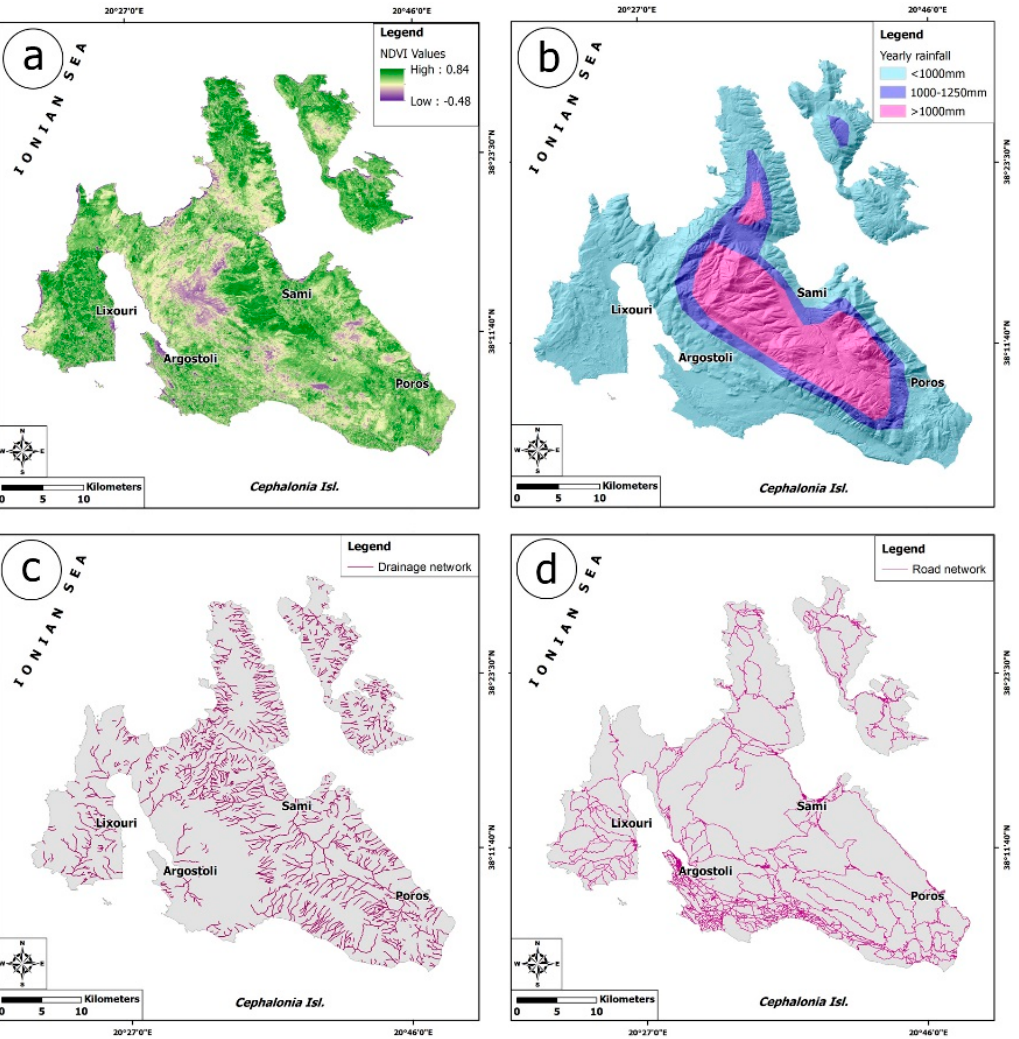
Figure 8. Thematic maps illustrating the environmental and hydrometeorological causal factors taken into account for the landslide susceptibility calculations. ( a ) NDVI, ( b ) yearly rainfall, ( c ) drainage network and ( d ) road network. Table 3. Thematic layers used in the study and their sources.